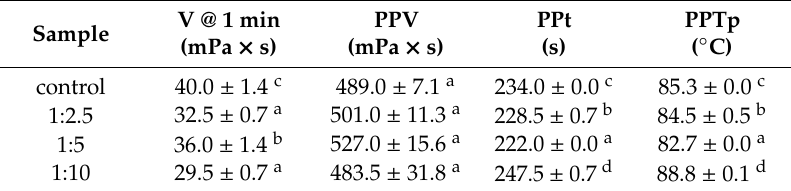
Table 4. Pasting process